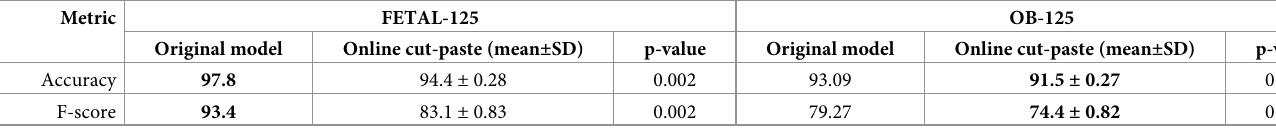
Table 4. Performance of model trained on hybrid data generated